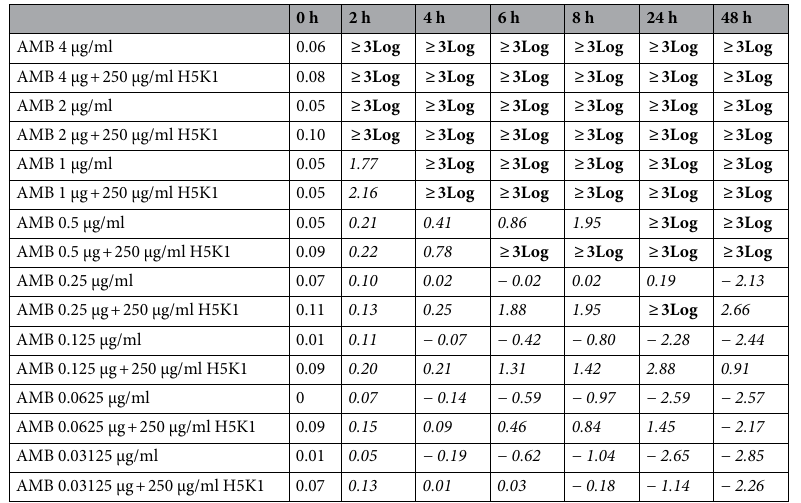
Table 7. ∆log of the samples with the starting inoculum. The fungistatic effect is in italic and the fungicidal in bold.